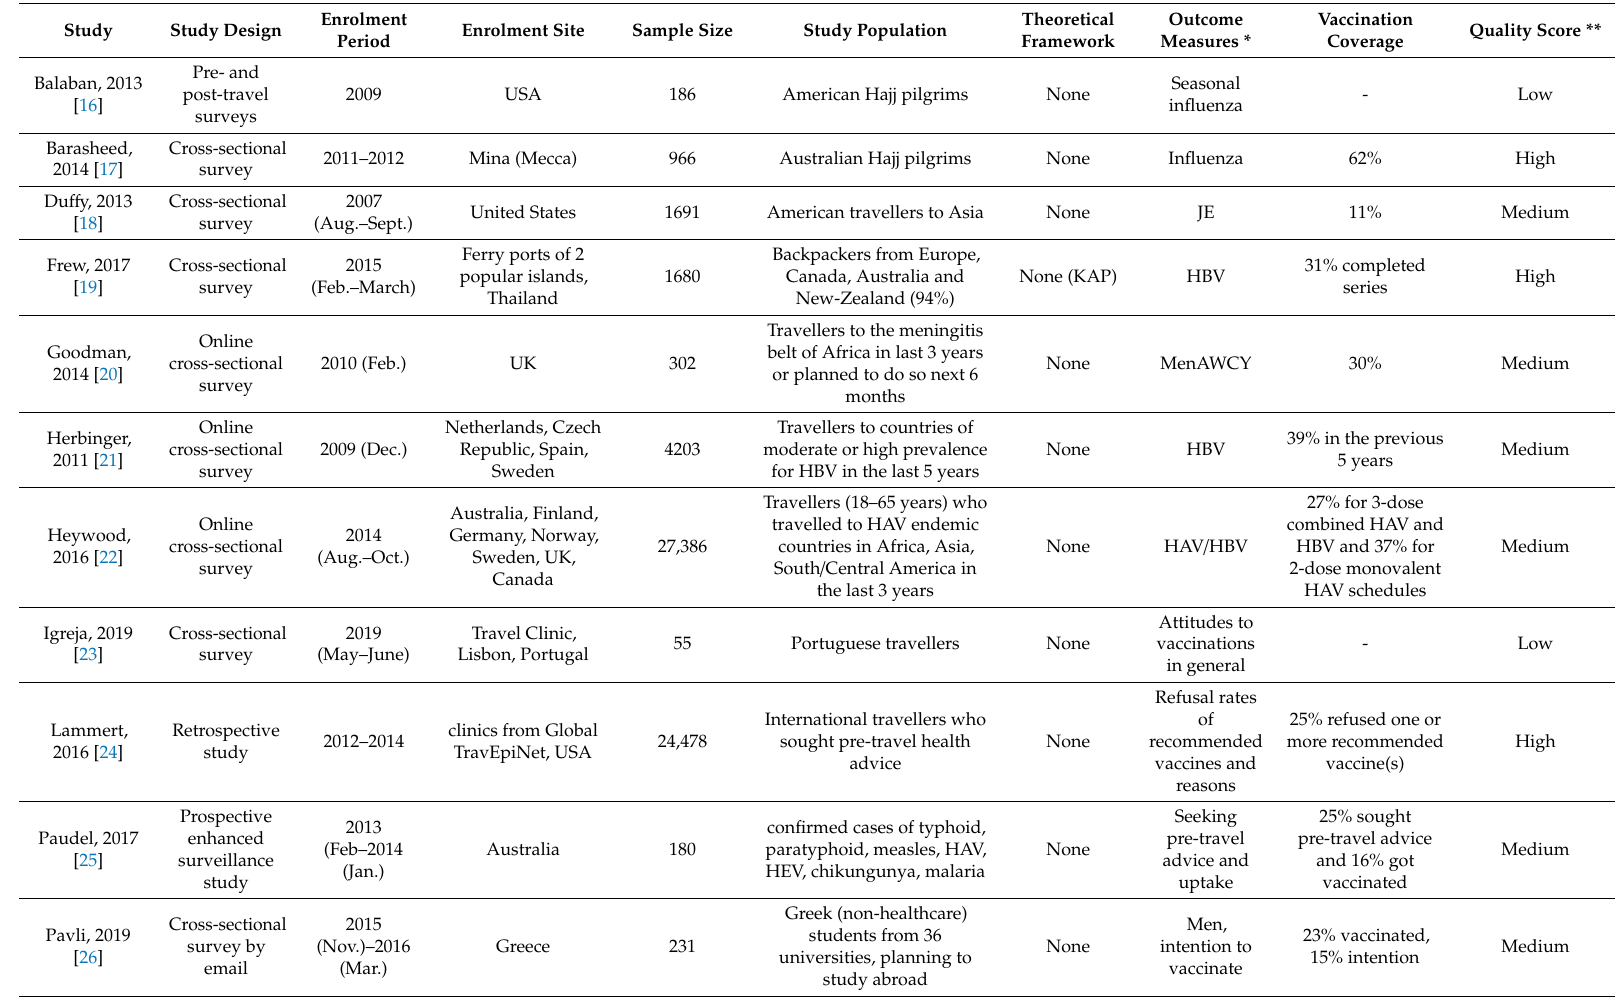
Table 1. Study characteristics of included studies for travellers, ICP and